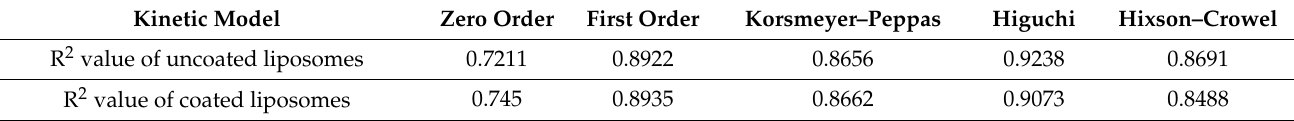
Figure 6. In vitro release study of PG in phosphate buffer (pH 5.6) ( a ) and in vitro permeability studies of uncoated- liposomes, coated liposomes, and PG solution ( b ). Table 5. R 2 values of drug release from uncoated and HA-coated liposomes.